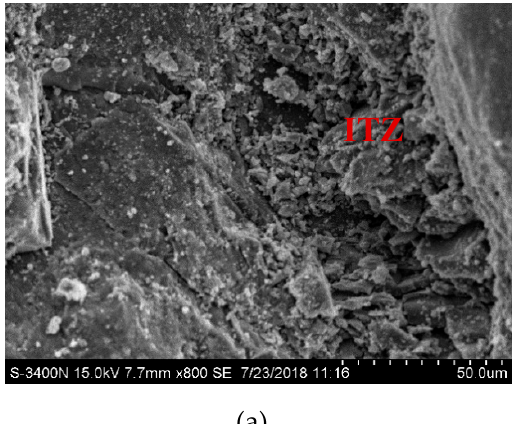
Table 7 Cracking time of RSERST and RRST specimen (h). M0